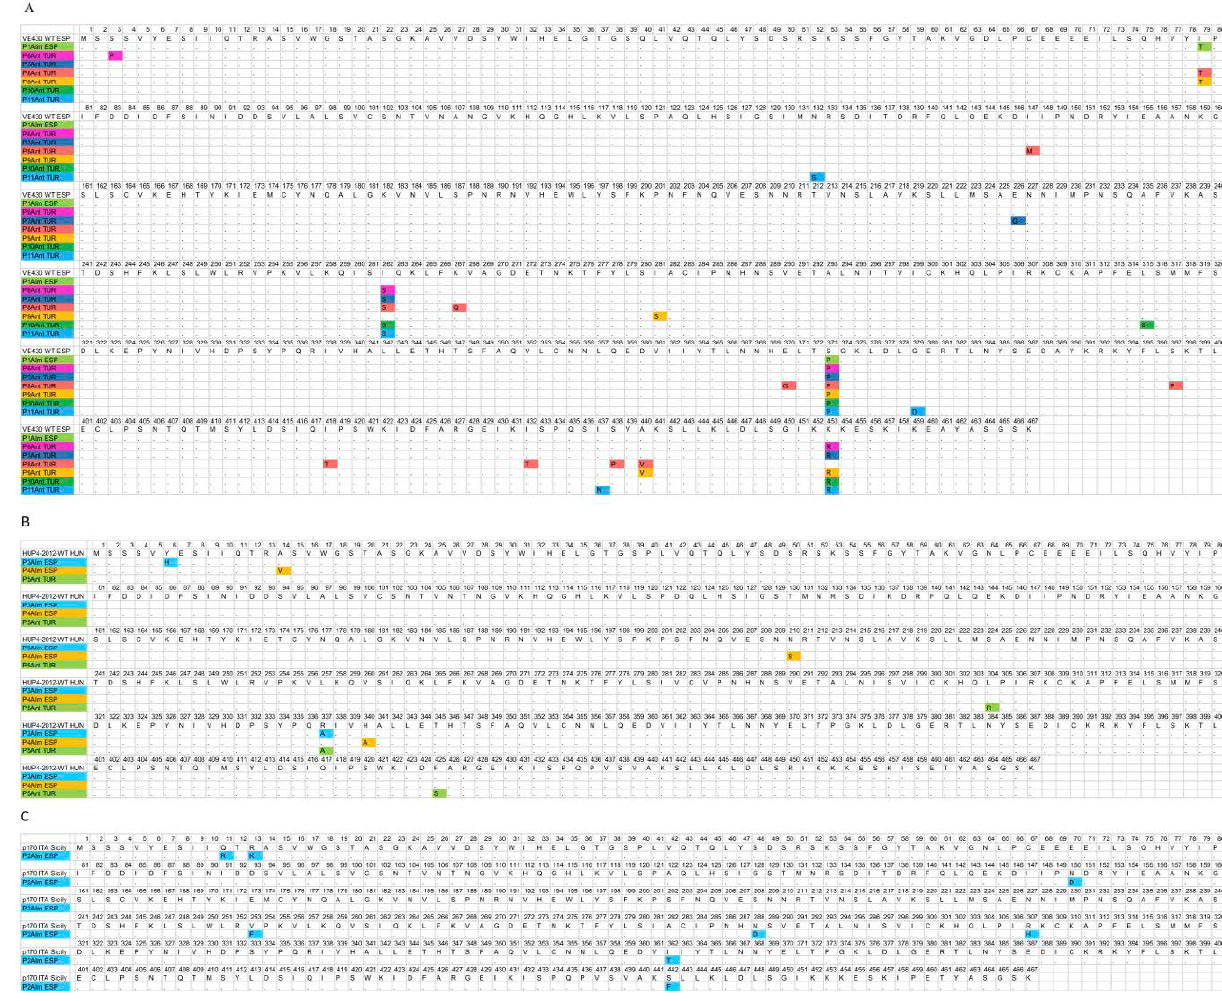
Figure 3. Amino acid sequence comparison of the NSs proteins of the isolated TSWV strains. The NSs amino acid sequences of RB strains (isolated in this study) were compared to the NSs amino acid sequences of the WT strains located in closest position on the phylogenetic tree. A : Strains P1Alm ESP, P7Ant, TUR, P8Ant TUR, P9Ant TUR, P10Ant TUR and P11Ant TUR are compared to the Spanish VE 430 WT ES strain. B: Strains P3Alm ESP, P4Alm ESP and P5Ant TUR are compared to the Hungarian HUP4-2012-WT HUN strain. C: Strain P2Alm is compared to the Italian P170 WT